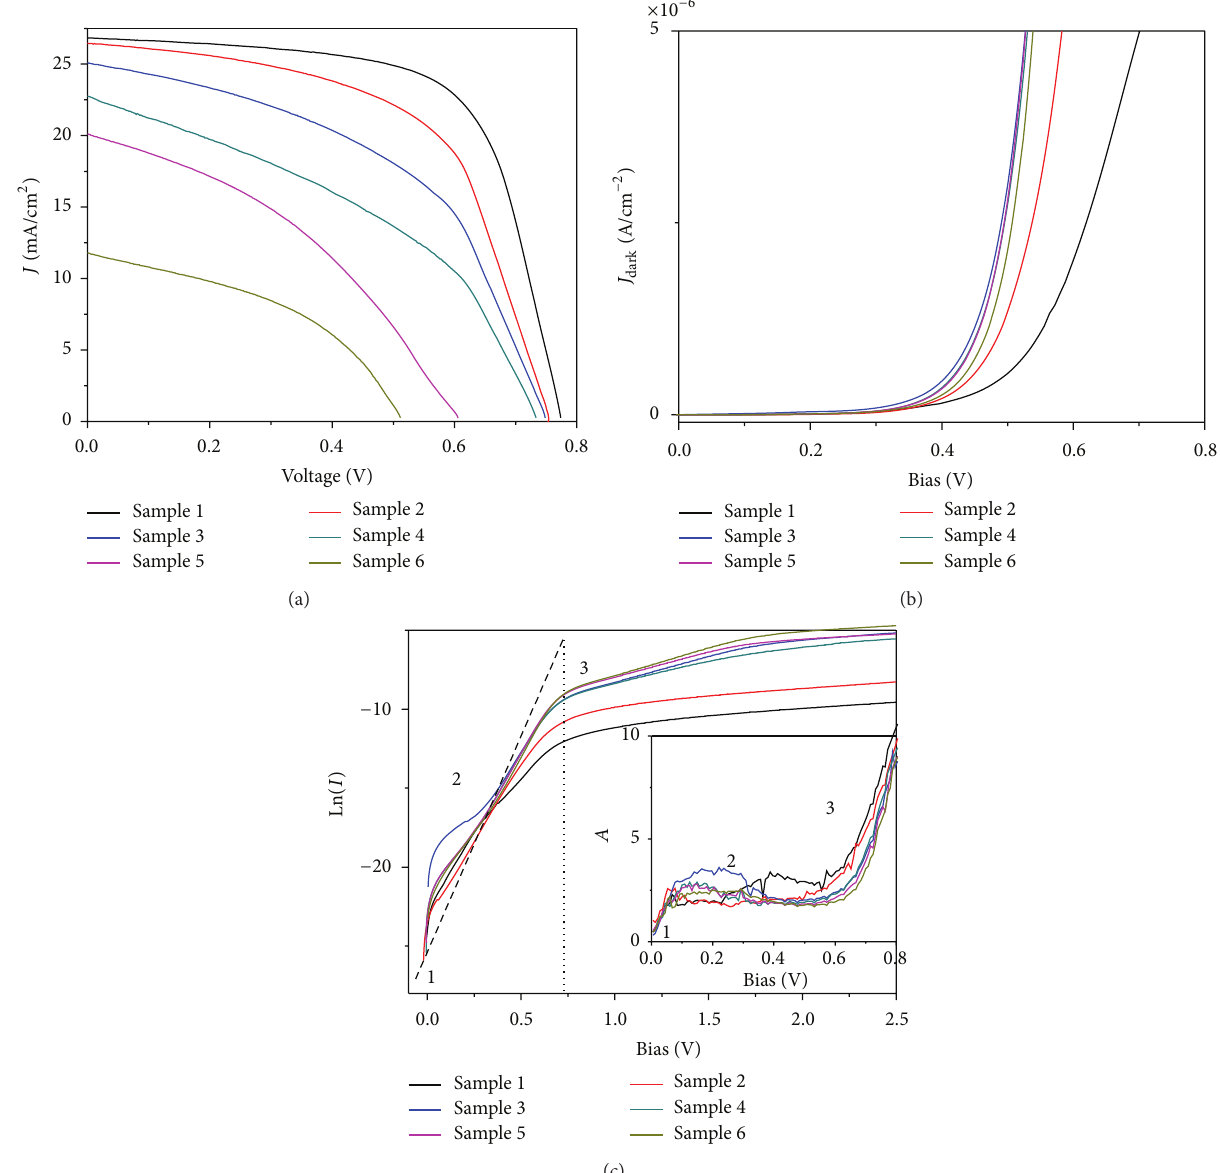
Figure 1: Plots of photocurrent (a) and dark current (b) versus bias of CdS/CdTe cells. (c) Plots of Ln 𝐼 versus 𝑉 for all cells. Inset showing the variation in diode ideality factor at different